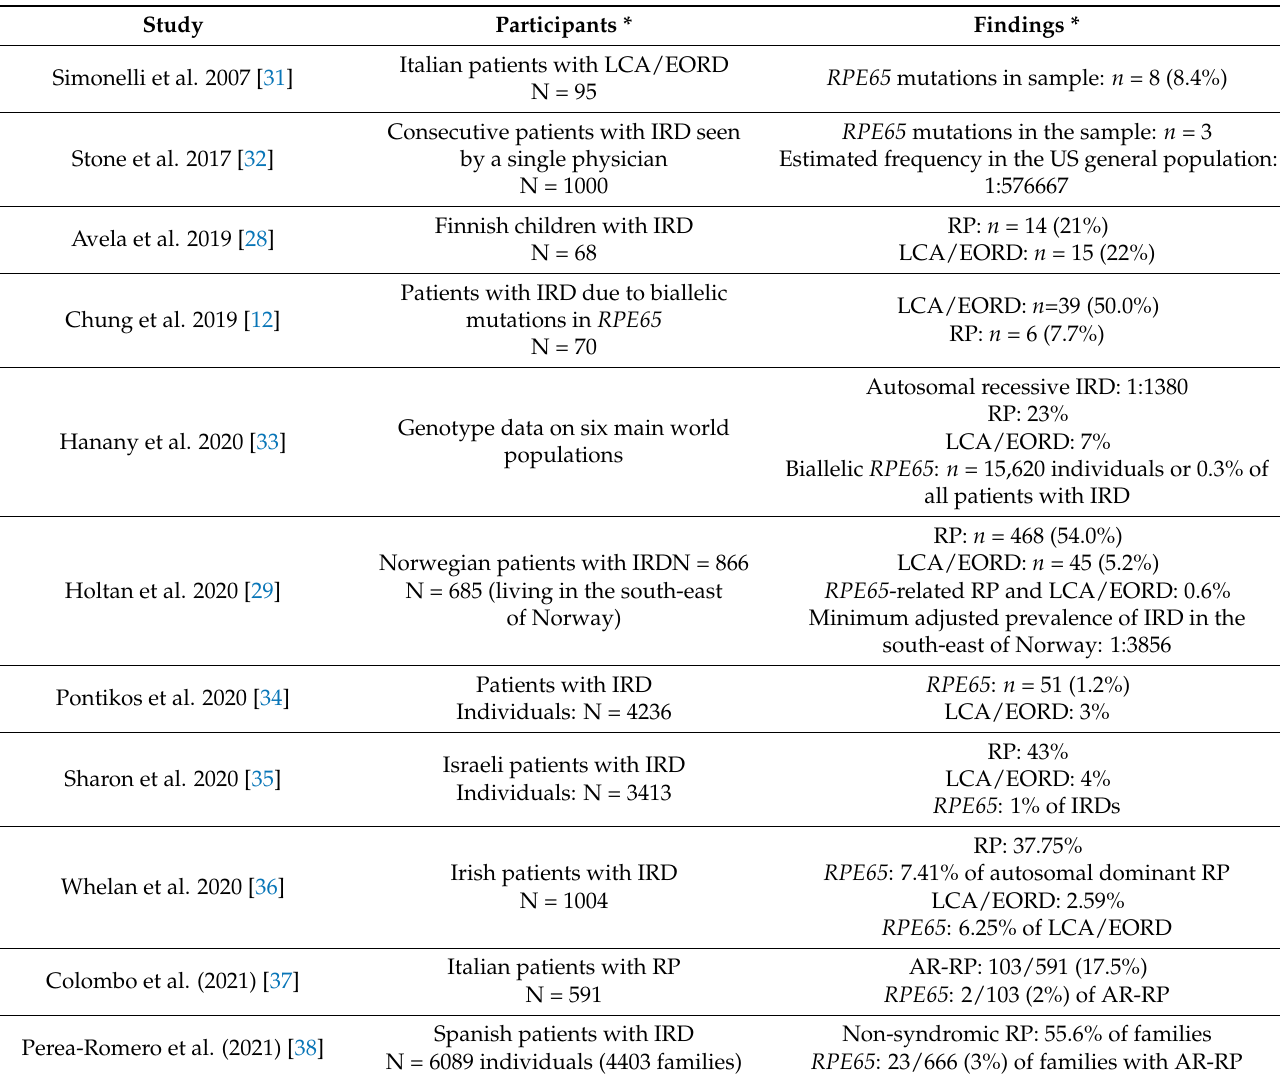
Table 1. Epidemiology of Leber congenital amaurosis, retinitis pigmentosa, and RPE65 -inherited retinal diseases. Study Participants * Findings * Italian patients with LCA/EORD RPE65 mutations in sample: n = 8 (8.4%) N = 95 Consecutive patients with IRD seen RPE65 mutations in the sample: n = 3 Estimated frequency in the US general